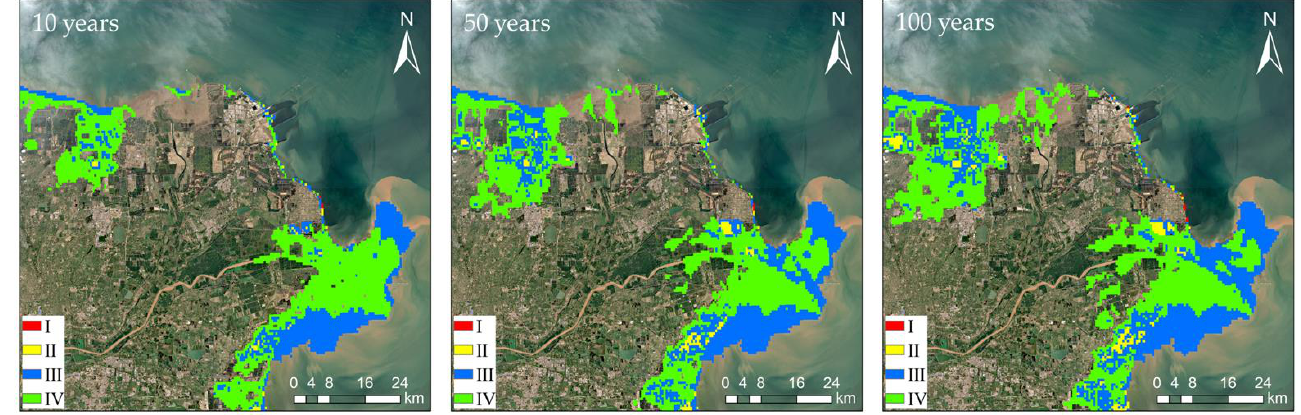
Figure 12. Risk map showing risk level of storm surge across the YRD in different return period winds.